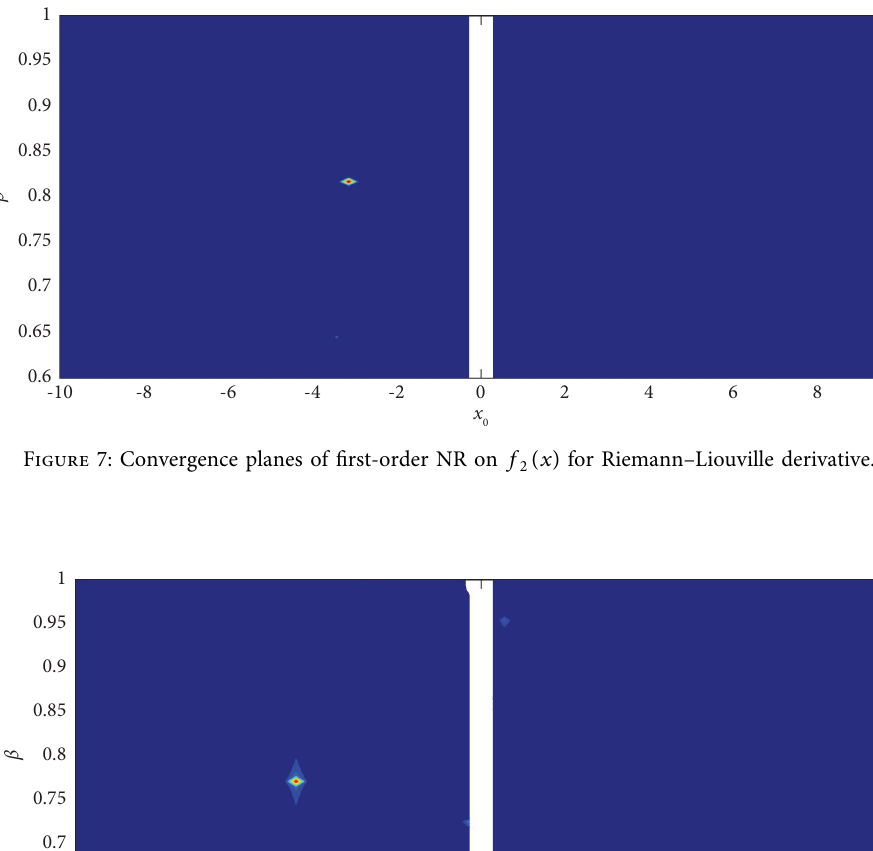
( x ) for Riemann–Liouville 2